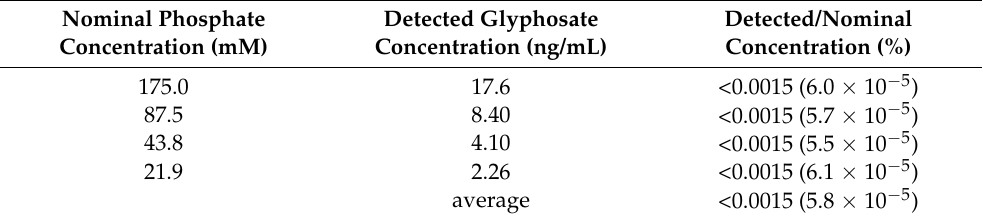
Table 4. Percentage cross-reactivity (CR%) of the antiserum with phosphate as a possible disturbing component in surface waters.